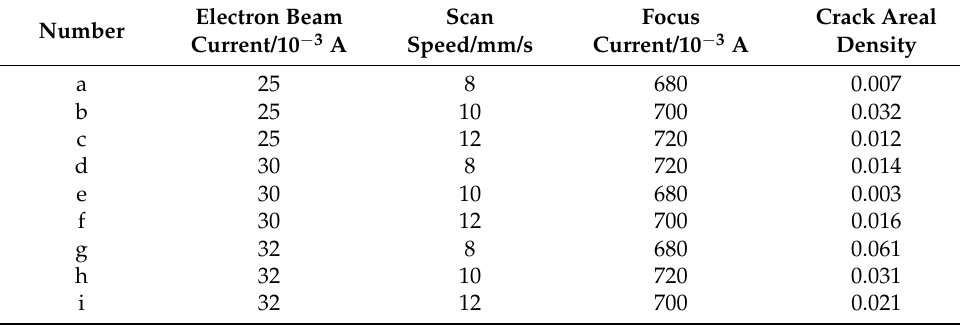
Figure 2. Picture of test crack. Table 4. Results of orthogonal experiment